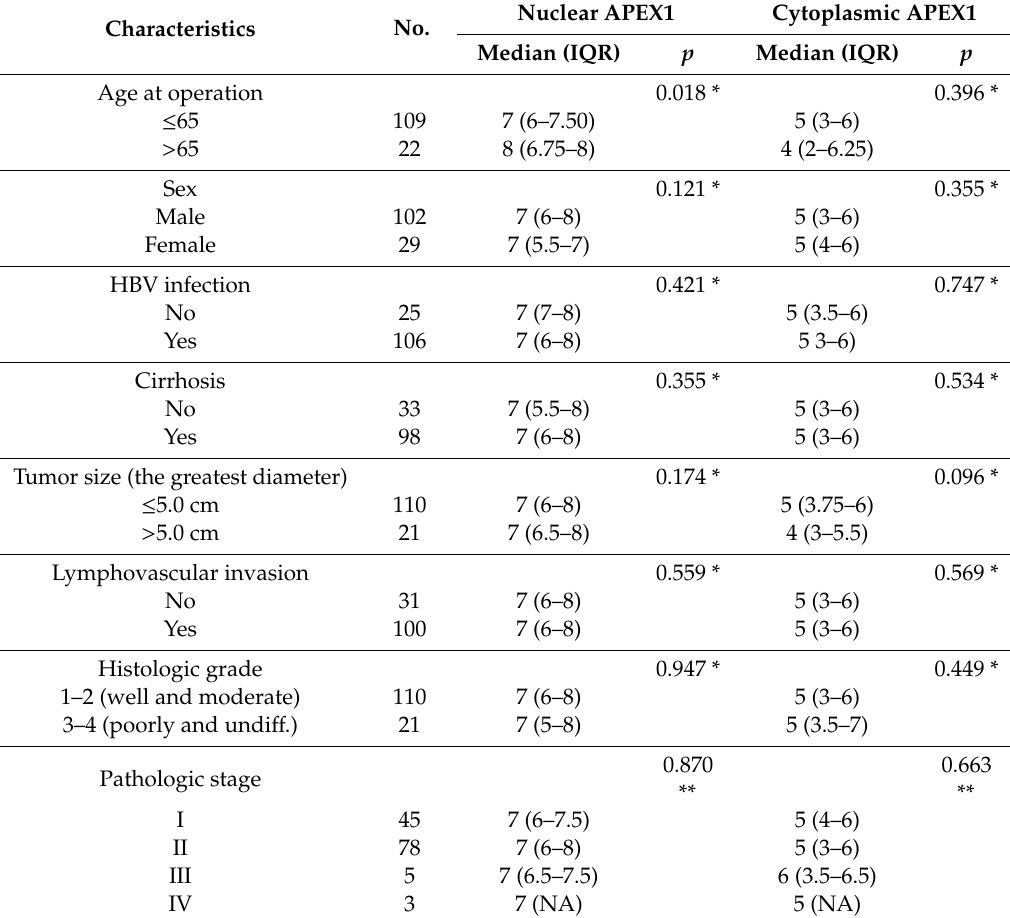
Table 3. Summary of the clinicopathologic characteristics of patients with hepatocellular carcinoma ( n = 131).